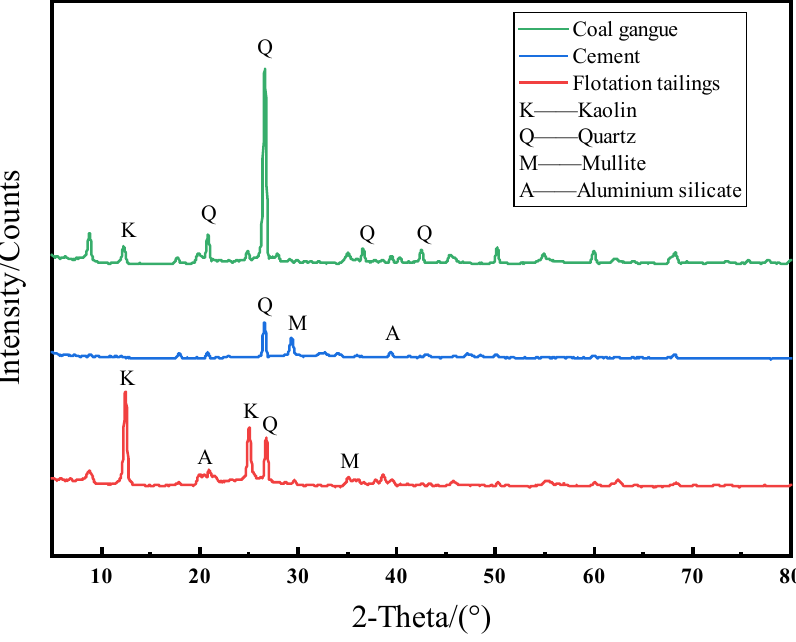
Figure 1. X-ray diffraction pattern of the raw material.